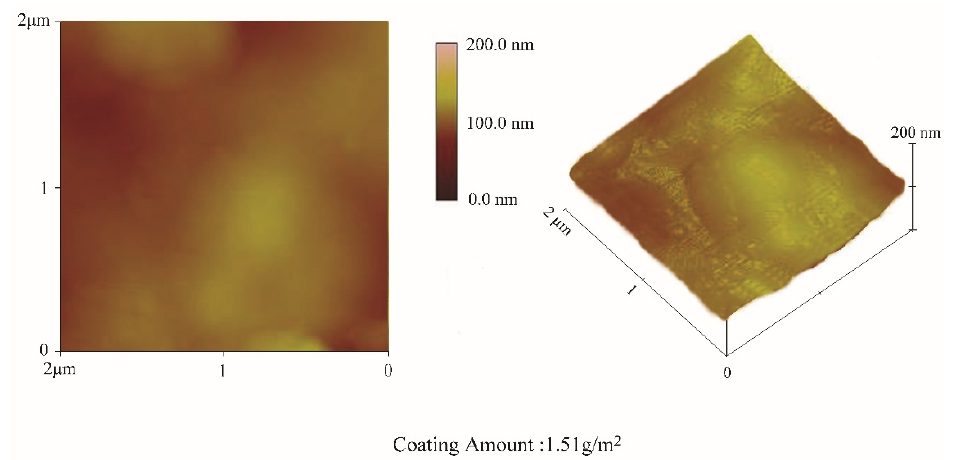
Figure 15. AFM views of the coated packaging paper (coating amount: 1.51 g/m 2 ).